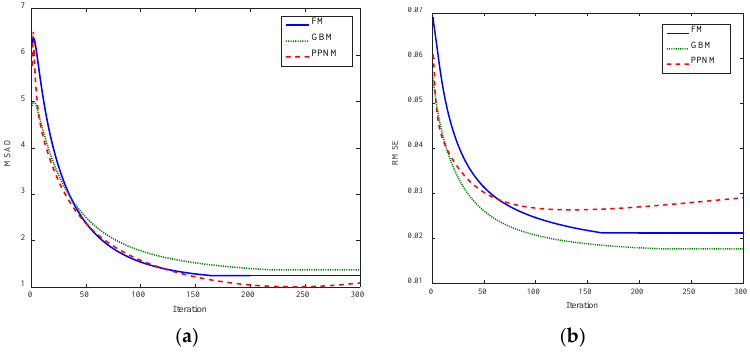
Figure 10. Convergence analysis of BMM-based constrained NMF algorithm (BCNMF): ( a ) MSADs; ( b ) RMSEs.